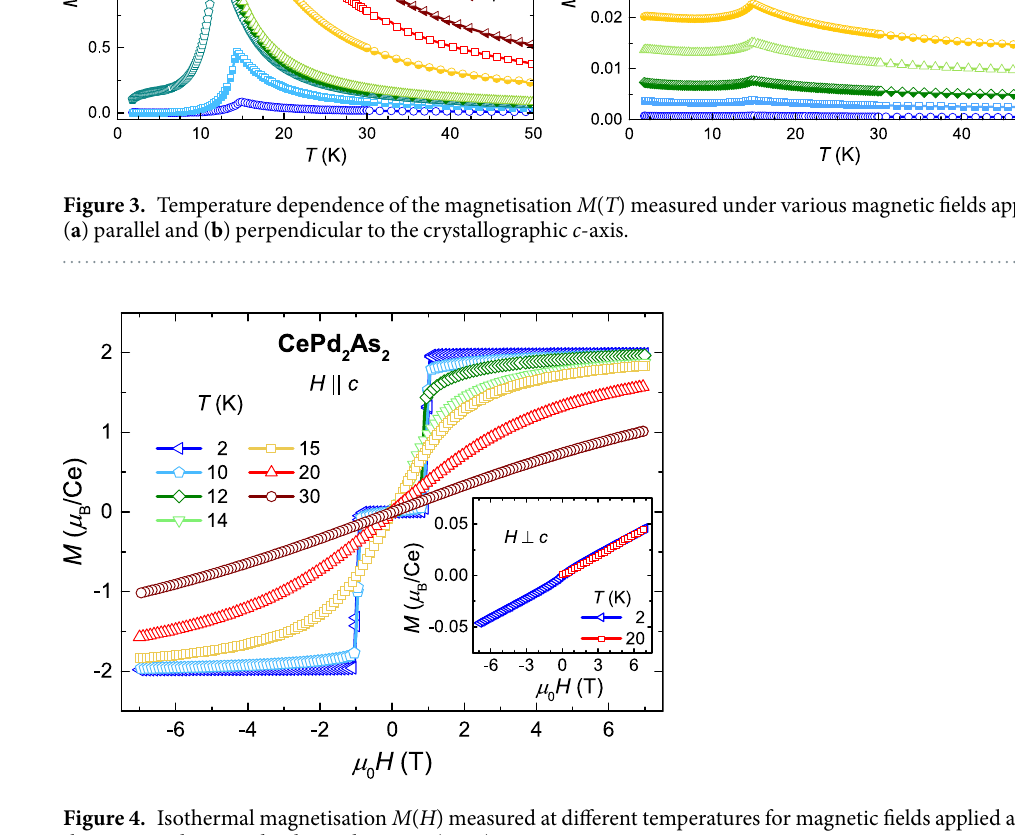
well-separated from the excited CEF levels and that the Kondo effect is rather weak. Further evidence for the localised character of the Ce moments comes from the magnetisation data discussed below. Magnetisation. Figure 3 presents the temperature dependence of the magnetisation measured under various magnetic fields applied parallel and perpendicular to the crystallographic c -axis. For H c , T N shifts to lower tem- peratures upon increasing the magnetic field, which is expected for an antiferromagnet. As the magnetic field approaches 1 T, the peak in M ( T ) corresponding to the AFM transition disappears and a broad step-like feature with a saturation of M ( T ) toward low temperatures develops. However, for H ⊥ c the position of peak correspond- ing to T N is independent of the magnetic field and still clearly visible at 7 T. These different behaviours reflect the large magnetic anisotropy present in CePd 2 As 2 . We note that, the sudden decrease in the magnetisation below T N for H c compared to that of H ⊥ c suggests that the crystallographic c -direction is the magnetic easy-axis. The isothermal magnetisation M ( H ) at 2 K, shown in Fig. 4, displays a sudden jump at μ 0 H c ≈ 1 T for H c followed by an immediate saturation. The observed saturation moment of 2.0 μ B /Ce is in reasonable agreement with the theoretical value of g J J = 2.14 μ B (where g J = 6/7) expected for a free Ce 3 + ion. The sudden jump in mag- netisation to the saturation value is a typical signature of a spin-flip metamagnetic transition. In the spin-flip process, the spins in the AFM sublattice, which are antiparallel to the field direction, are flipped at H c . Hence, the antiferromagnetism changes to a field-polarised phase in a sudden, single step. The sharp nature of the jump in magnetisation with a small hysteresis point to a first-order type transition. At higher temperatures, the metama- gnetic transition in M ( H ) broadens and saturates at much higher fields. In the case of H ⊥ c (inset of Fig. 4), the magnetisation increases monotonously and reaches at 7 T only 2.5% of the saturation value for H c . Furthermore, magnetisation measurements in pulsed fields up to 60 T show a linear increase without any tendency to saturation (not shown). This suggests the absence of any metamagnetic transition for H ⊥ c , which stipulates the huge mag- netic anisotropy in CePd 2 As 2 .